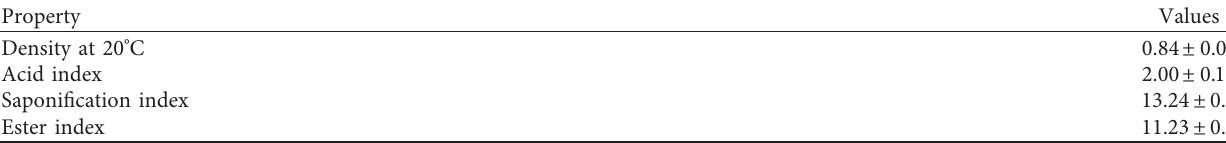
Table 1: The physicochemical indexes of the essential oil of the Halimium halimifolium .